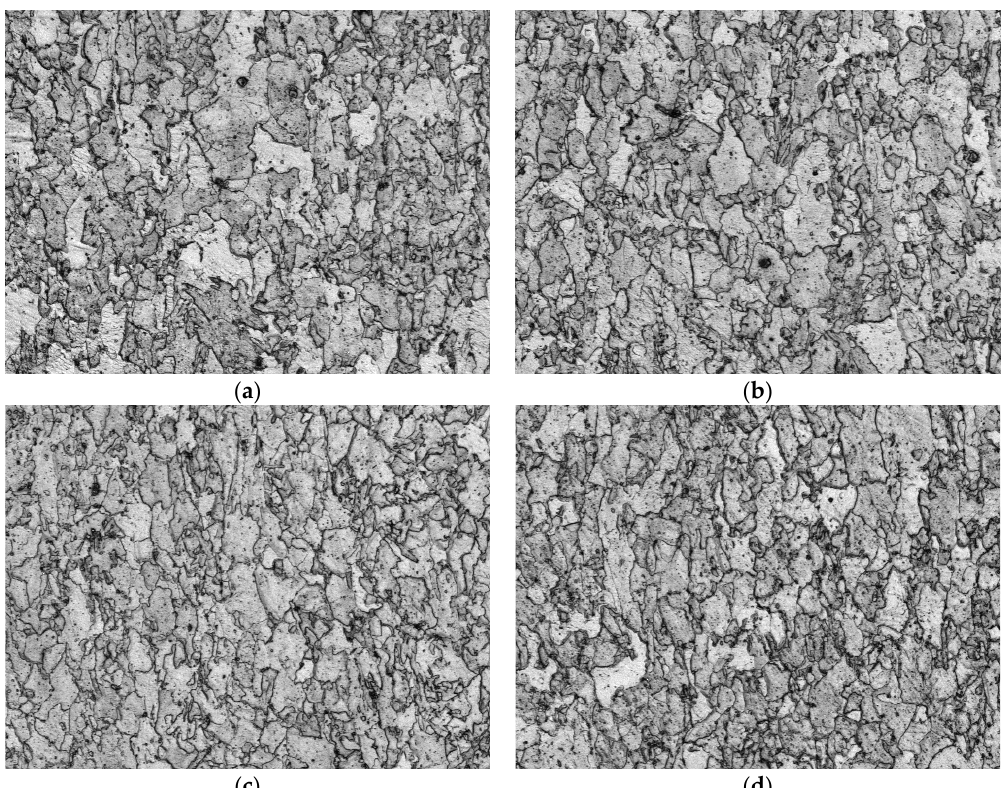
Figure 4. Metallurgical structures under close-door furnace cooling, 500x: ( a ) S1; ( b ) S2; ( c ) S3; ( d ) S4.